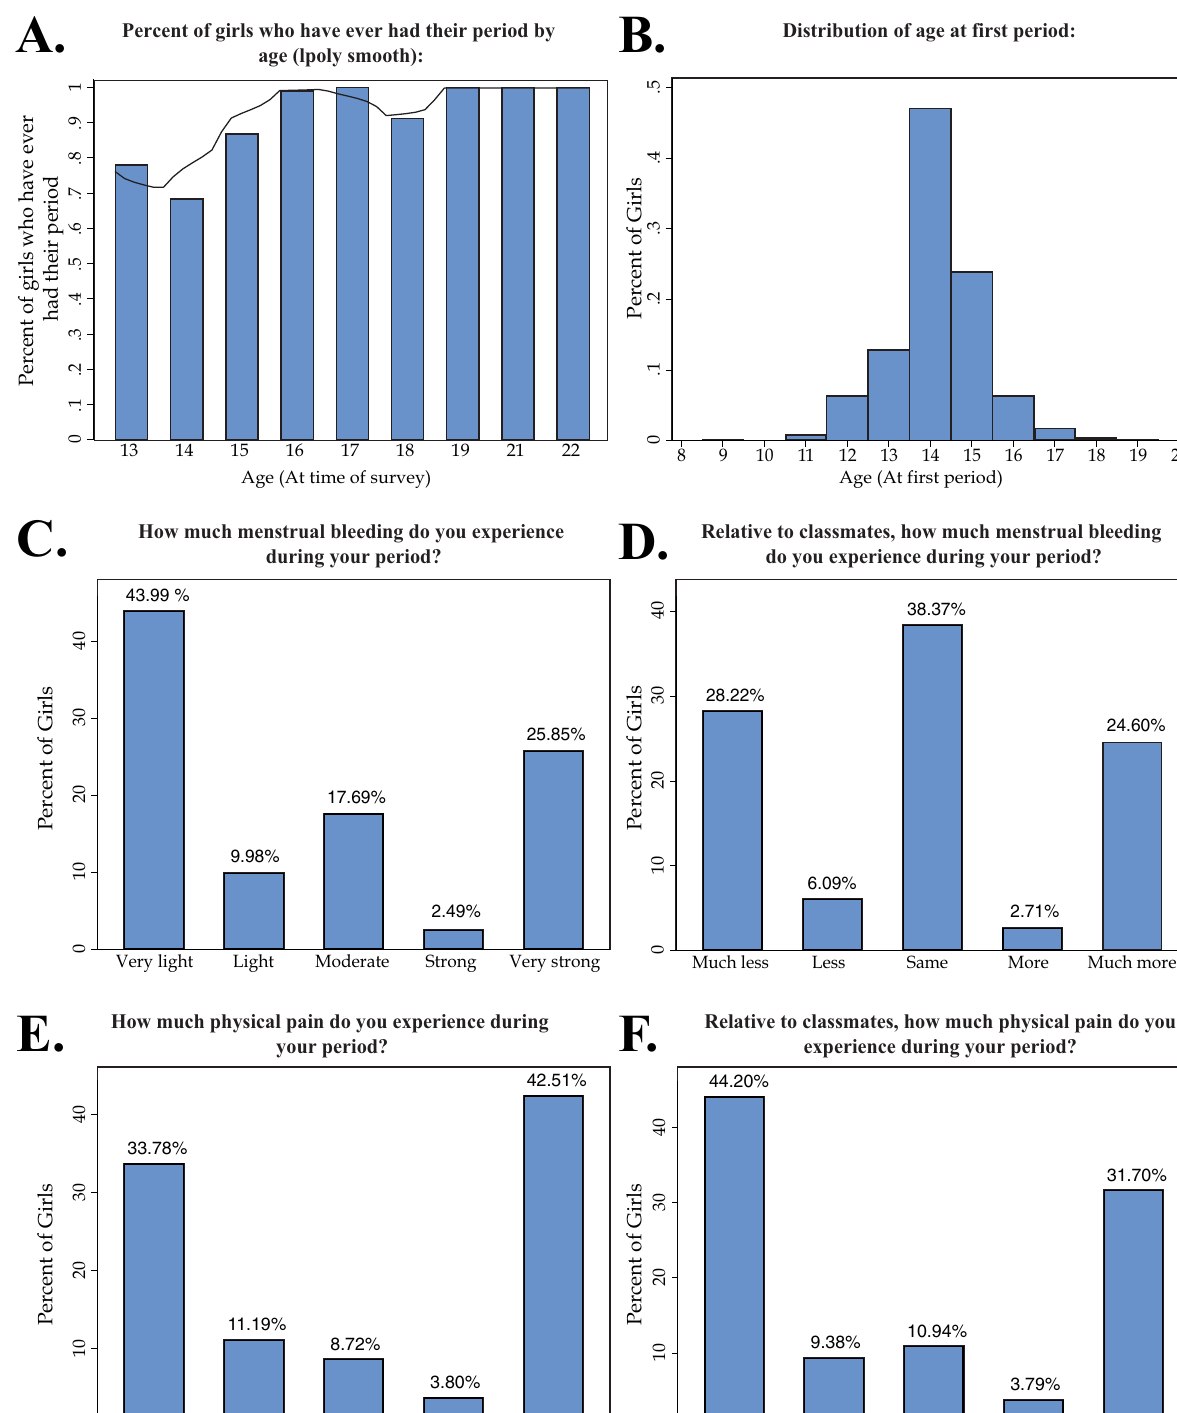
Fig 1. Age of menarche and degree of pain and bleeding during menstruation. The sub-figures included provide relevant information regarding the samples’ experiences with pain and bleeding during menstruation as well as age of menarche. A) The percent of girls who have ever had their period separated by their age during surveying. The figure includes a local polynomial smooth. B) A histogram showing the distribution of age at first period. C) “How much menstrual bleeding do you experience during your period?” D) “Relative to classmates, how much menstrual bleeding do you experience during your period?” E) “How much physical pain do you experience during your period?” F) “Relative to classmates, how much physical pain do you experience during your period?”.